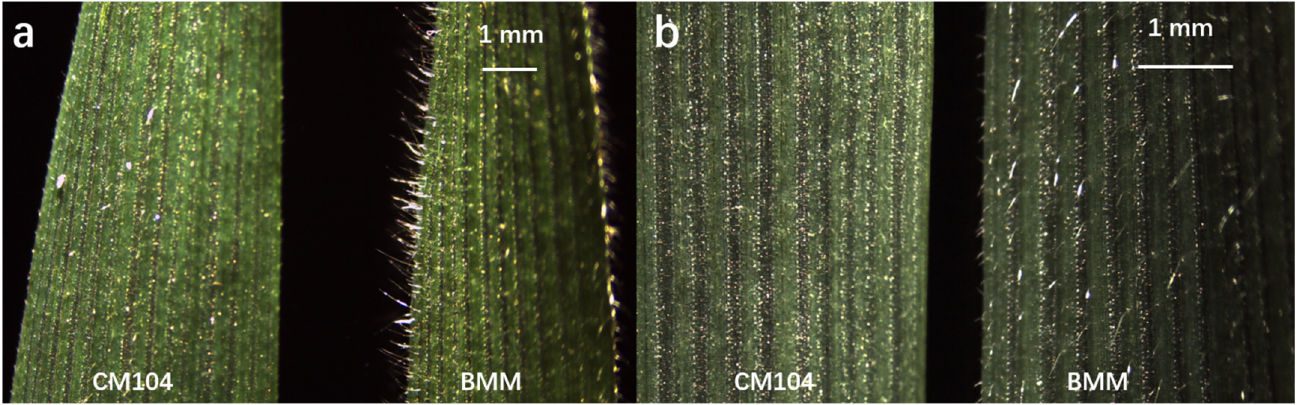
Figure 1. Leaf pubescence phenotypes of the parents Chuanmai104 (CM104) and Baimaomai (BMM) observed with a stereomicroscope at the heading stage: ( a ) the lateral observation of leaf surface; ( b ) the frontal observation of leaf surface.